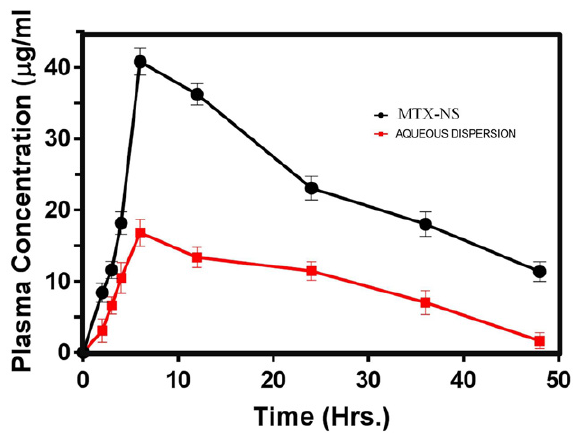
Figure 12. Plasma concentration-time profiles of MTX after oral intake of MTX-NS and the MTX-AQD formulation in rats. Each value represents the mean ± S.D. (n =